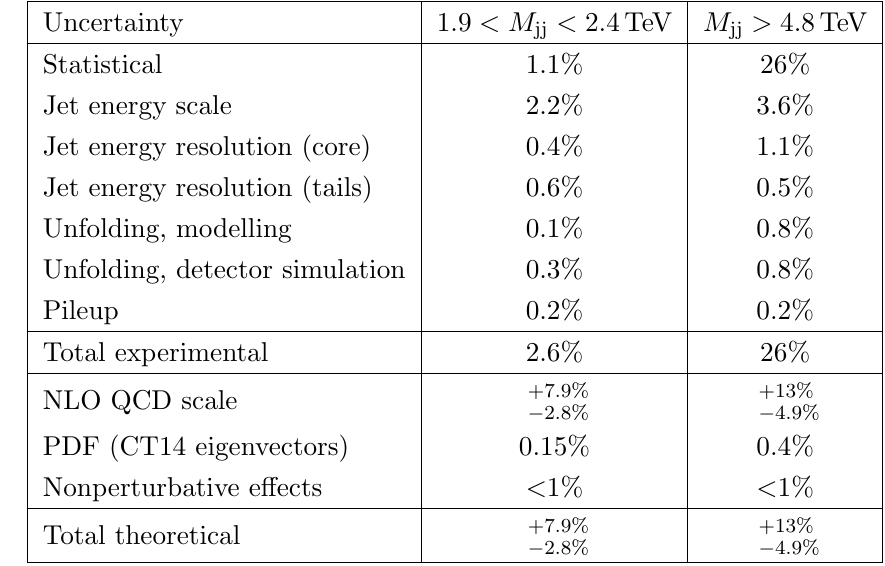
Table 1 . Summary of main experimental and theoretical uncertainties in the normalized (cid:31) dijet distributions. Although the change in the (cid:31) dijet distribution from each uncertainty is taken into account in the statistical analysis, this table summarizes the uncertainty in just the smallest (cid:31) dijet bin, for the smallest and largest bins in dijet mass. The uncertainty in the dijet bin with largest mass is dominated by the statistical experimental contribution, while the theoretical contribution is dominated by the uncertainty in the NLO QCD